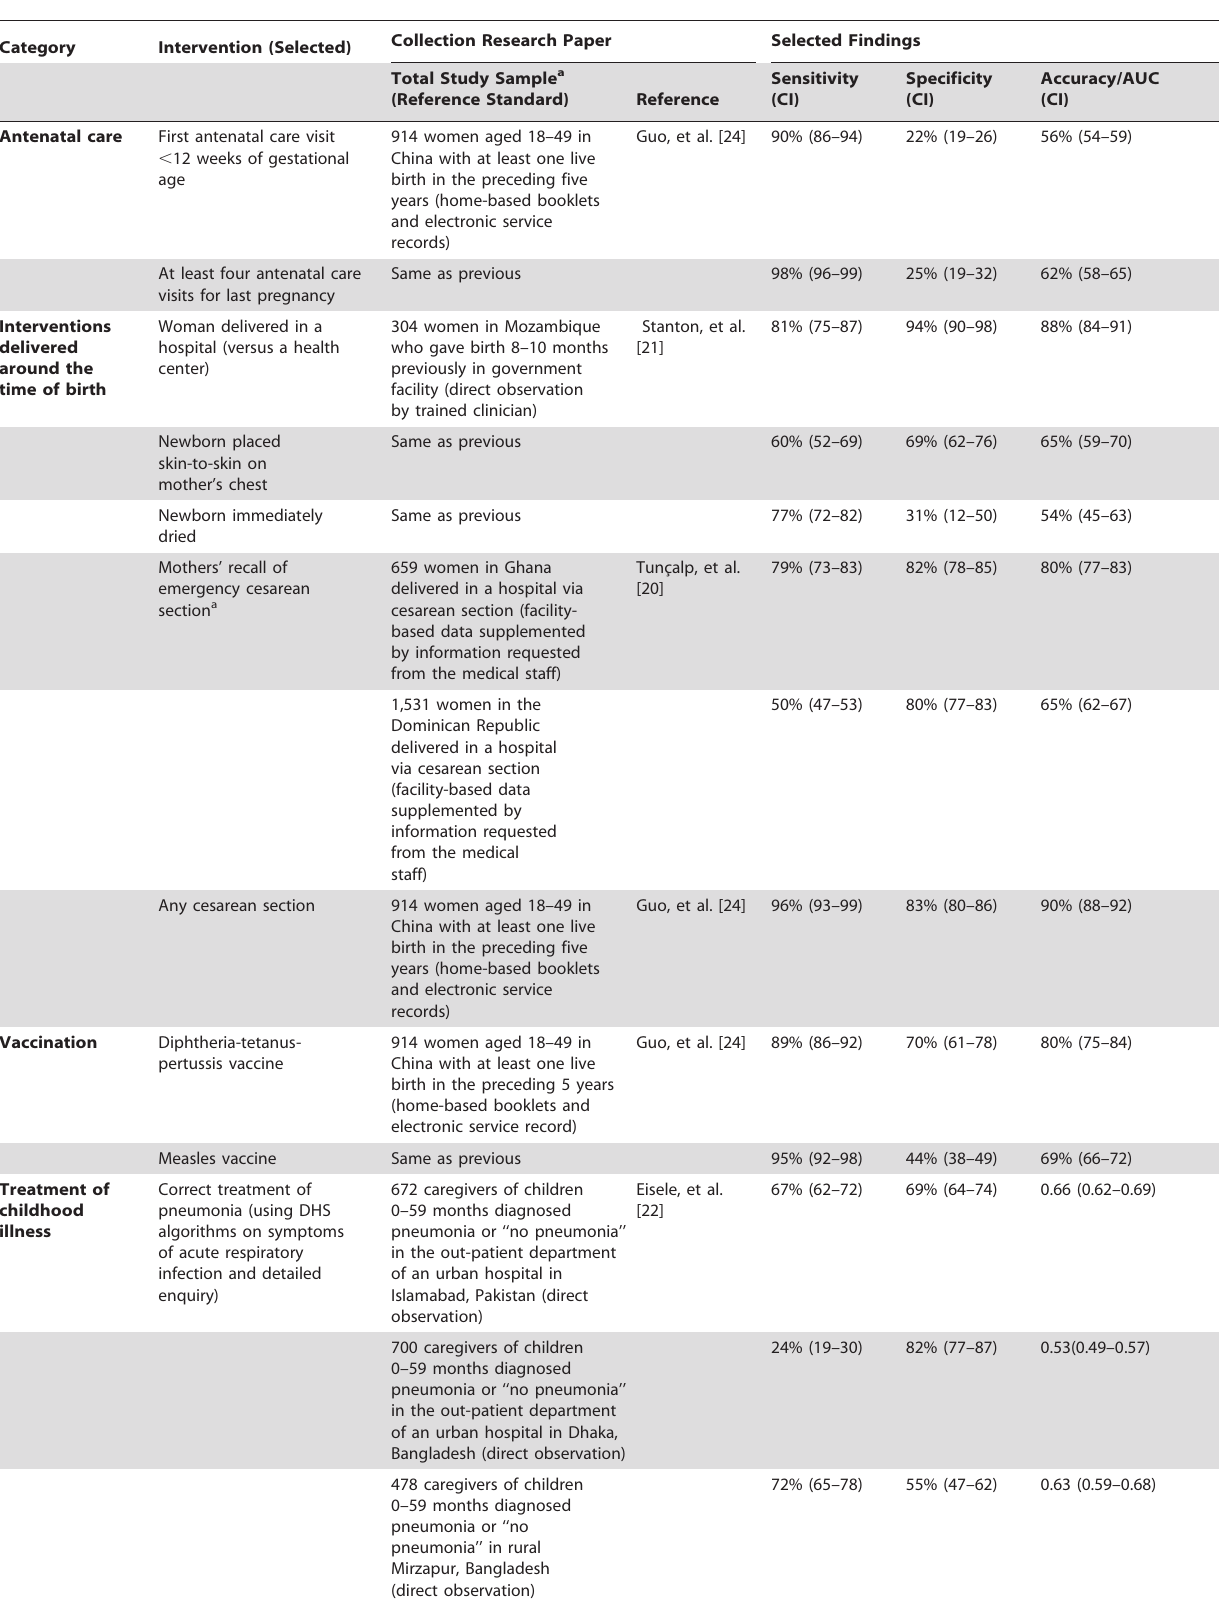
Table 1. Selected Collection research findings on respondents’ reports of intervention